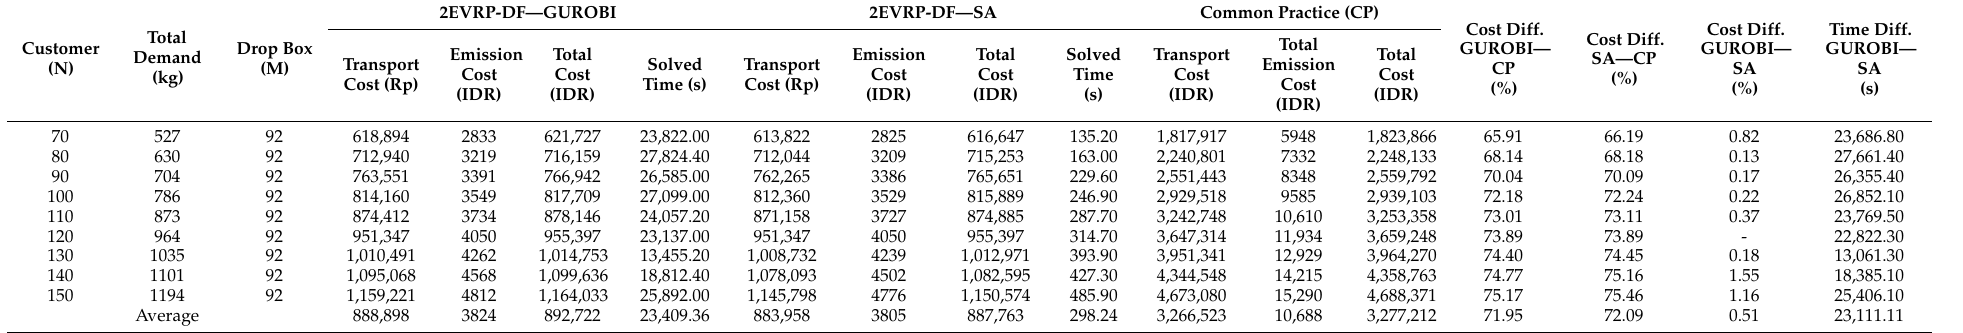
Table 4. Comparison of results between 2EVRP-DF and common practice on large size